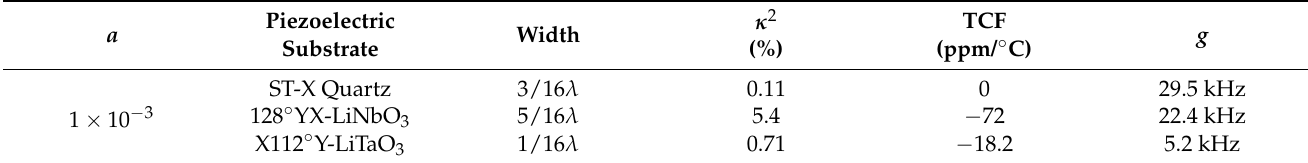
Table 2. SAW gyroscopic effect of different piezoelectric